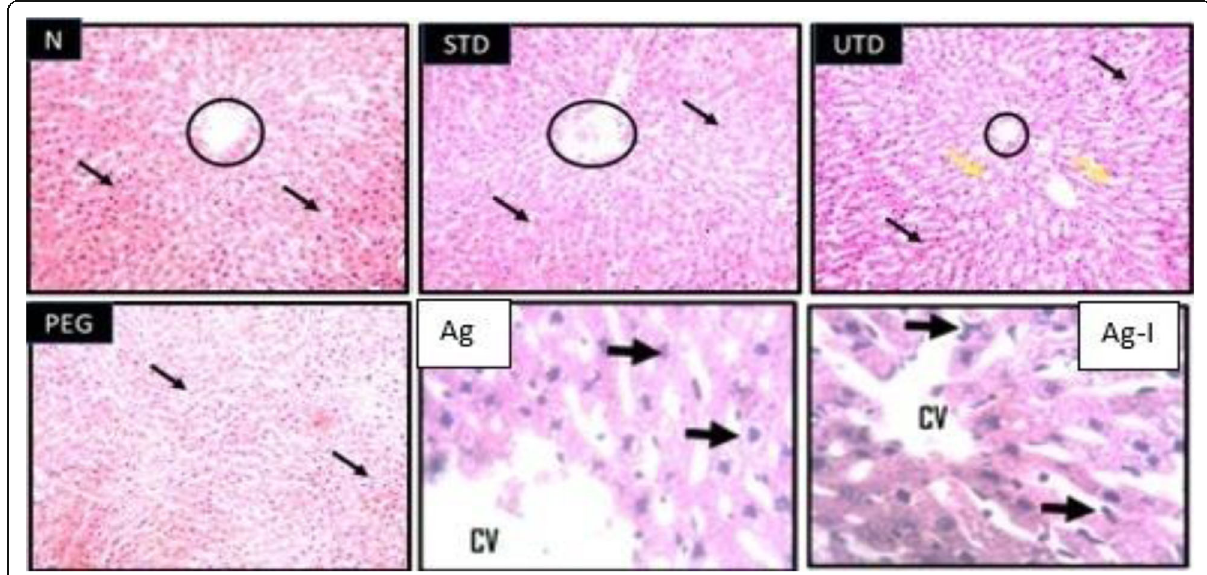
Fig. 1 Effect of PEG, Ag-NP, and Ag-I NP treatment on histological sections of liver in excision wound inflicted albino rats. Hematoxylin and eosin stain at × 100 and × 400 magnification